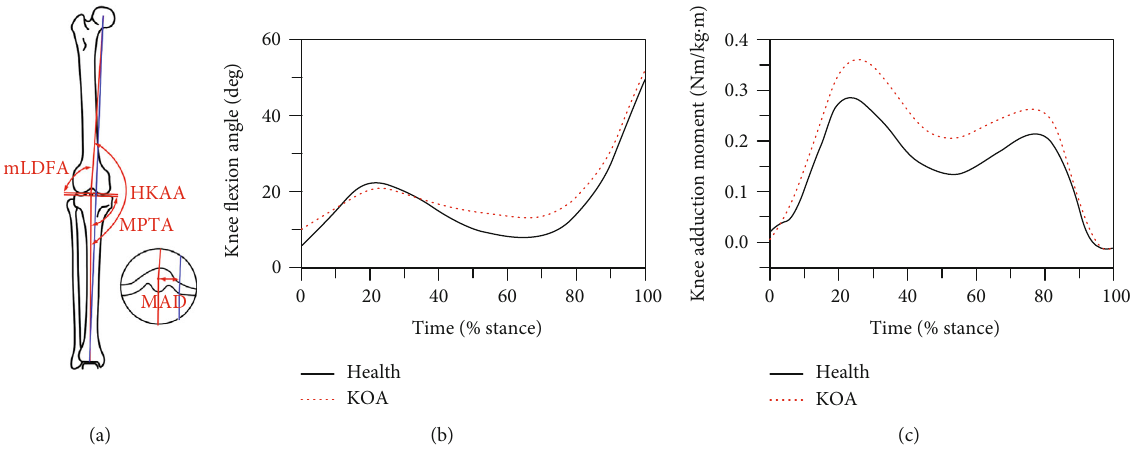
Figure 7: The knee alignment measurement methods and the e ff ect of KOA on fl exion angle and adduction moment. (a) Sketch map of HKAA, mLDFA, MPTA, and MAD [61]. (b) Knee fl exion angles of health and KOA individuals [48]. (c) Knee adduction moments of health and KOA subjects